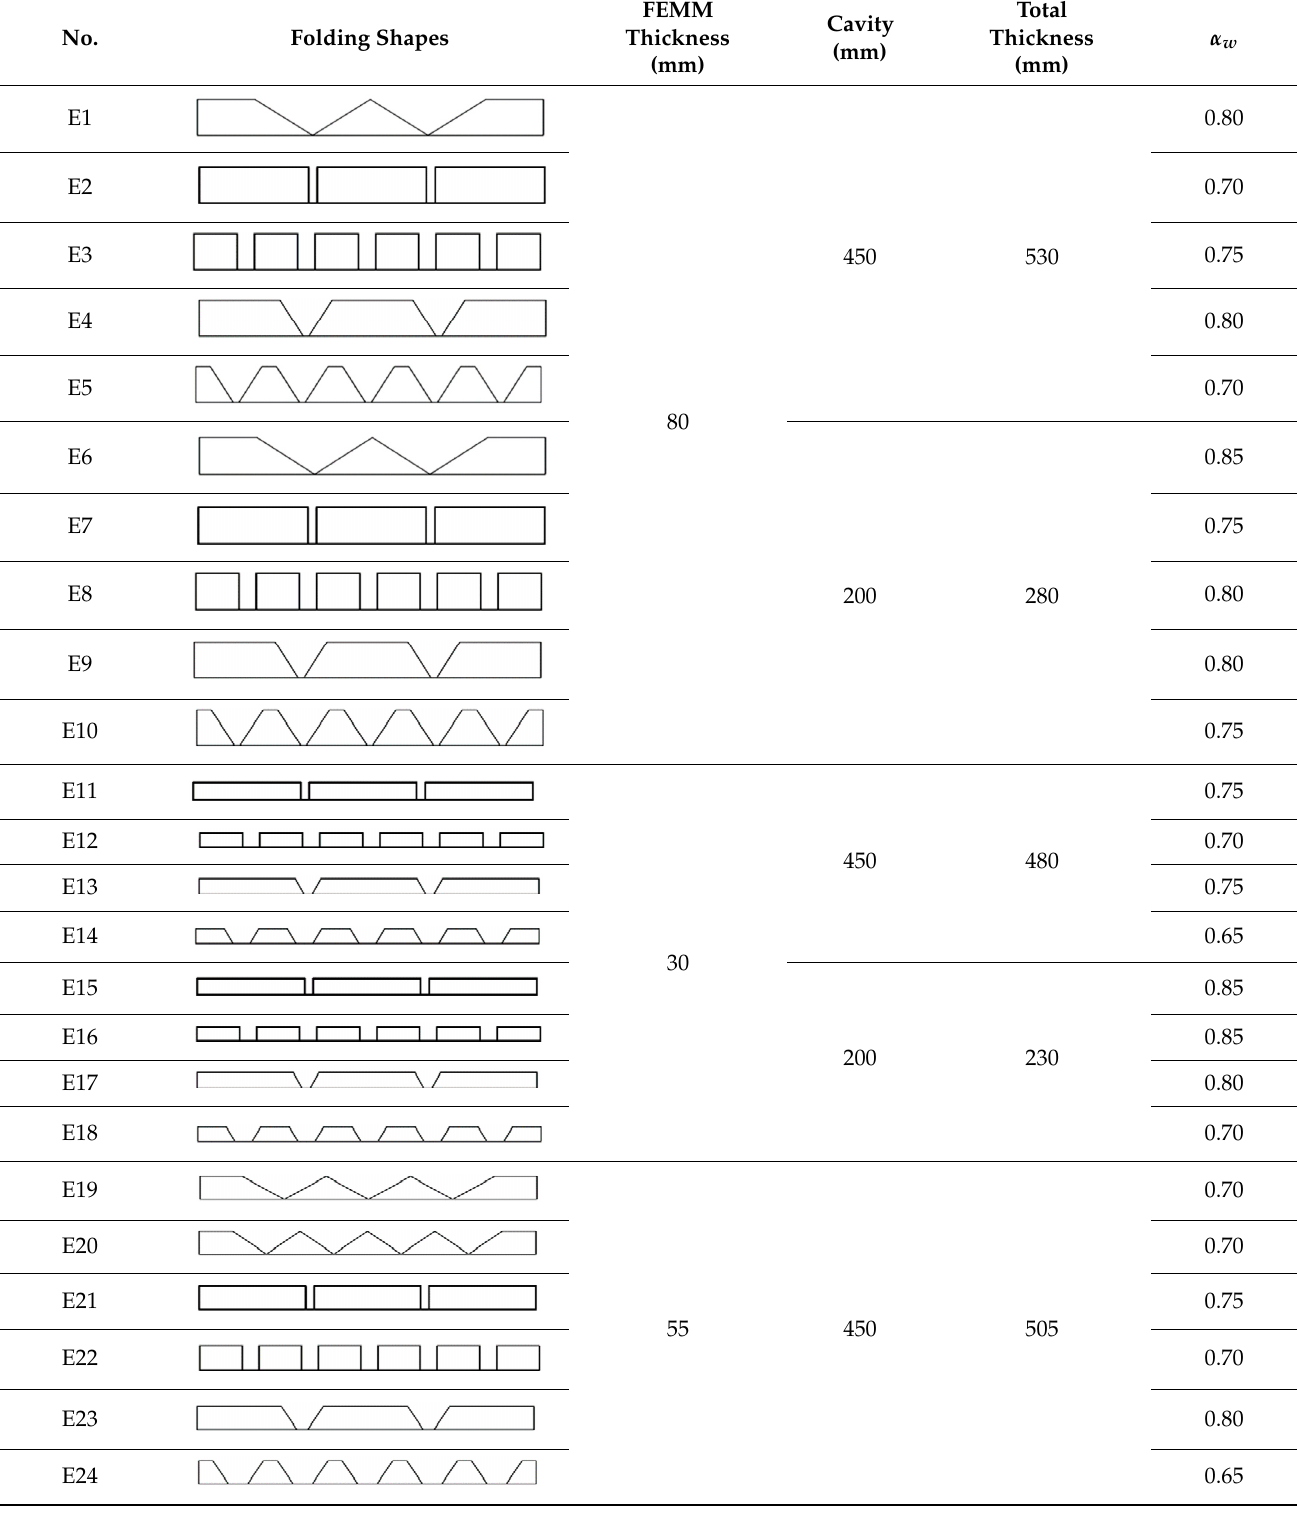
Table 2. The specimen setting and measurement results of folded expanded metal mesh (FEMM).